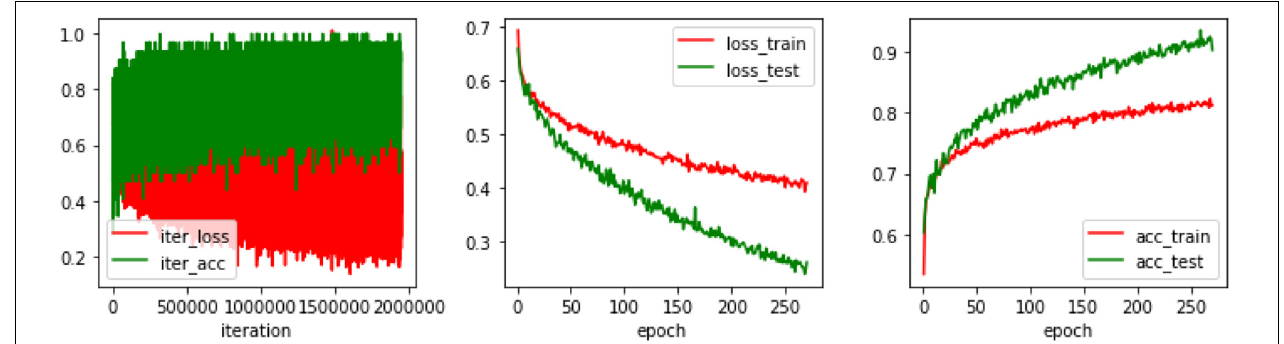
FIGURE 6 | Process of model